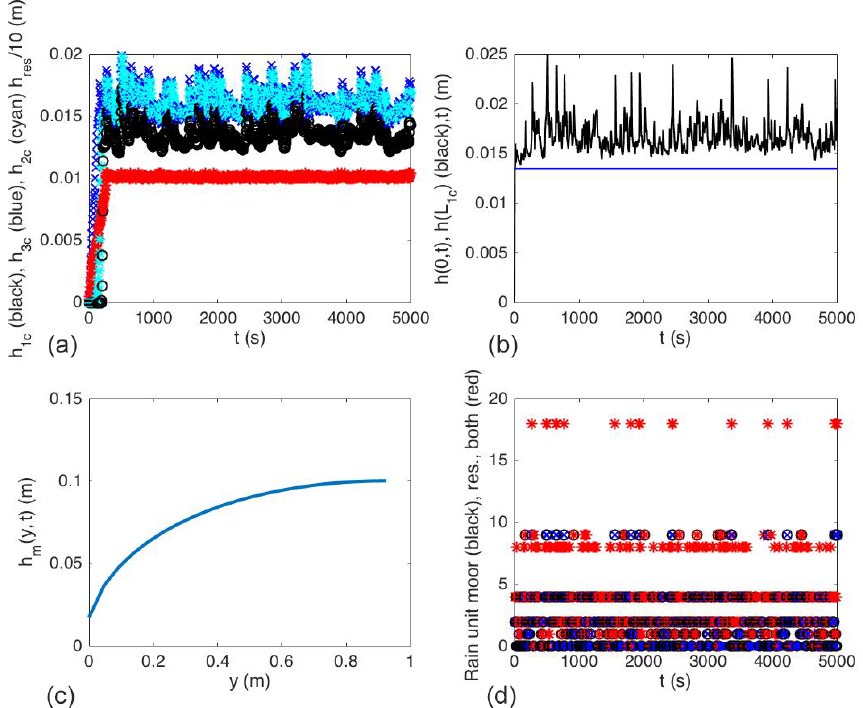
Figure 5. A four-panel figure in which (a) contains the three canal levels and the level of the reservoir as a function of time t , all initialised at zero in this run (reservoir: red; canal-1: black, canal-2: cyan; canal-3: blue); (b) displays the river level at s = 0 in blue and the river level at one point in the city in black as a function of time; (c) shows moor groundwater level h m (y , t) as a function of space y in a snapshot at t = 5000s; and (d) shows rainfall per wd = 10s scaled with the magic factor r 0 versus